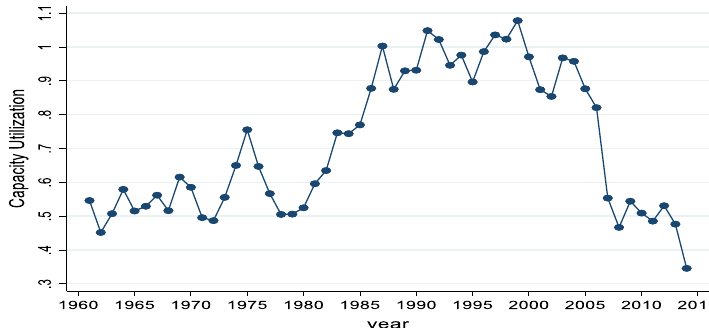
Fig. 7 Estimated cost-based capacity utilization